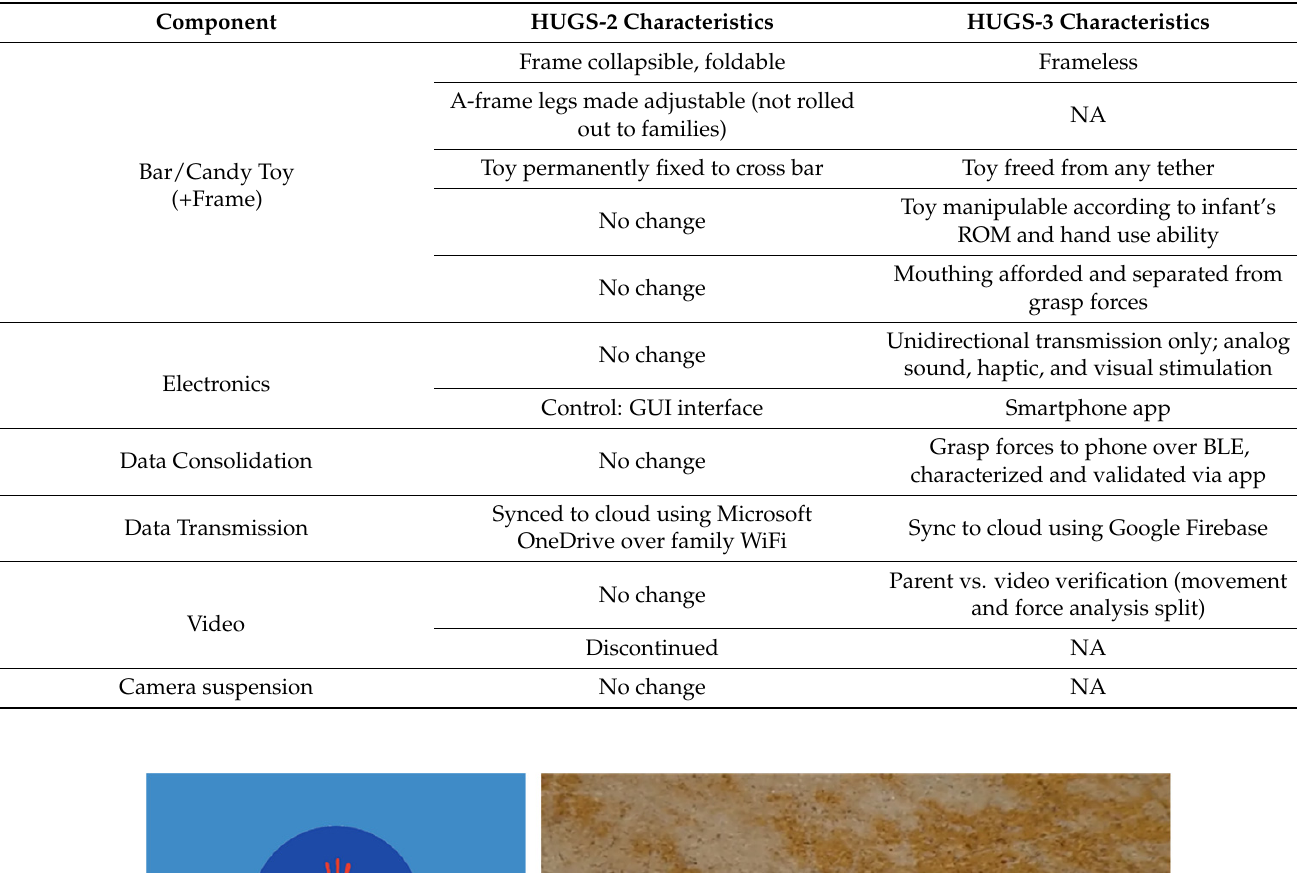
Table 5. Continuing evolution: HUG-2 migration to HUGS-3.